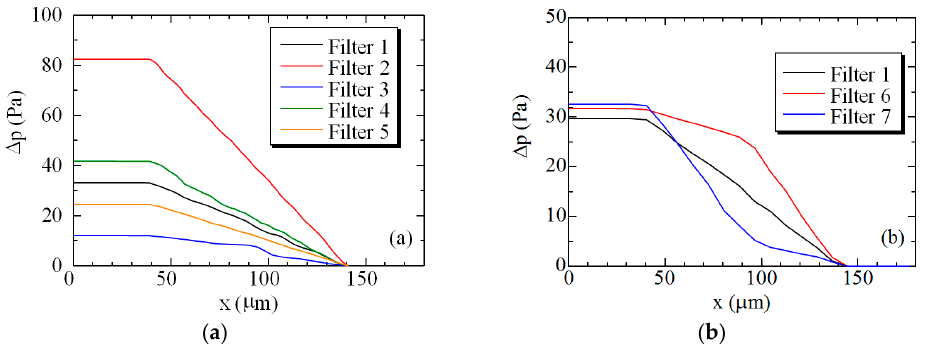
Figure 6. Distribution of pressure averaged in y-z plane; ( a ) Filters 1 to 5; ( b ) Filters 1, 6, 7.